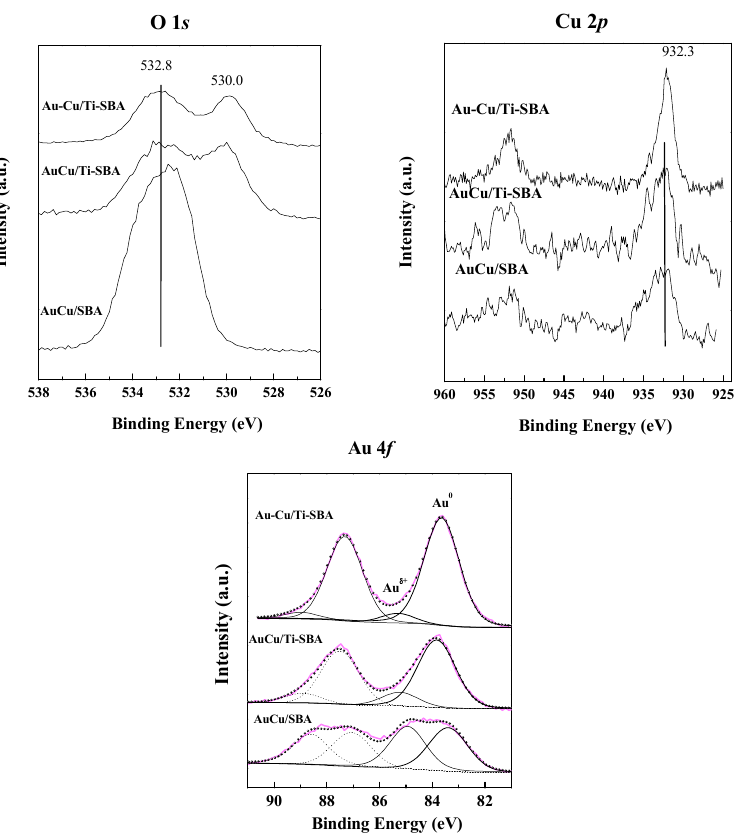
Figure 9. Si 2 p , O 1 s , Ti 2 p , Cu 2 p and Au 4 f core-level spectra of the prepared samples.